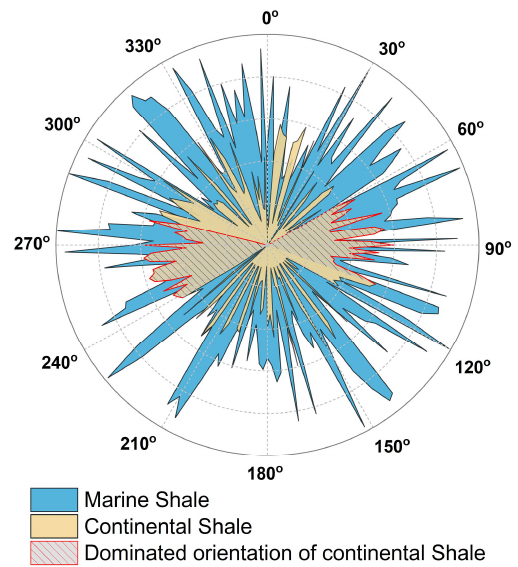
Figure 10. The relative length and angle of clay minerals distributed in marine and continental shale (the relative length is calculated based on Equation (1)). The angle represents the clay mineral orientation based on the same calibrated bedding plane. Moreover, the degree of sparsity represents the dominated orientation (60–110° and 238–285° are the dominated orientation for continental shale, whereas there is no dominated orientation of clay mineral in marine shale).